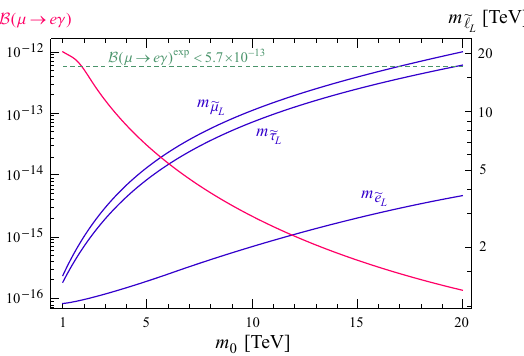
Figure 5 . Left slepton masses and B ( (cid:22) ! e(cid:13) ) as a function of the SUSY breaking scale m 0 , with ( m 2 [1 TeV]) phys given in eq. L